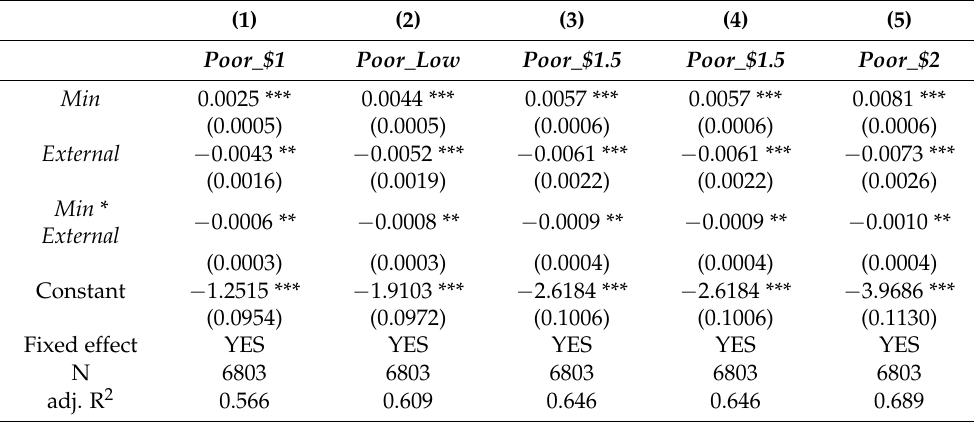
Table 13. Impact of extreme low temperature on poverty vulnerability—migrant workers.